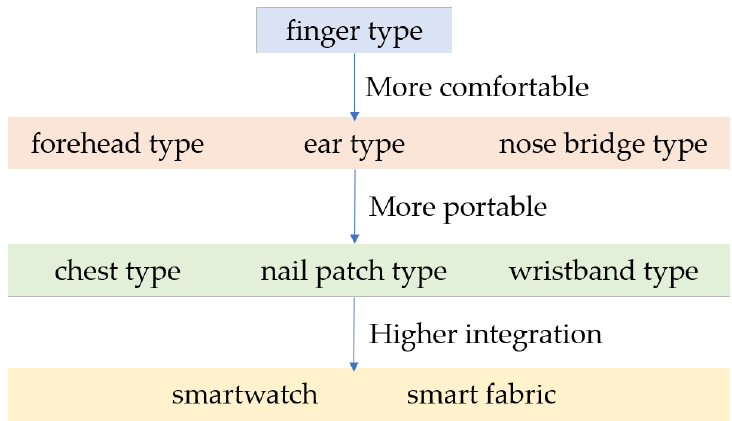
Figure 10. The development of PPG technology.